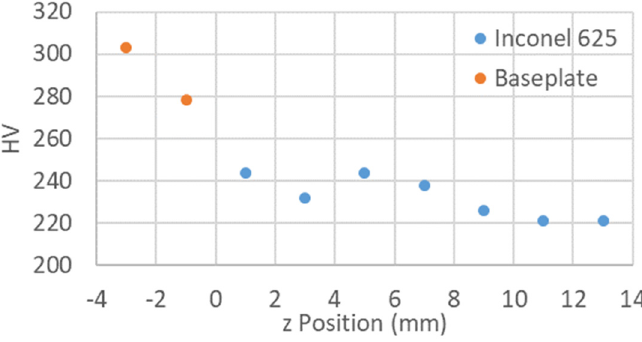
Figure 12. Vickers hardness. Figure 12. Vickers